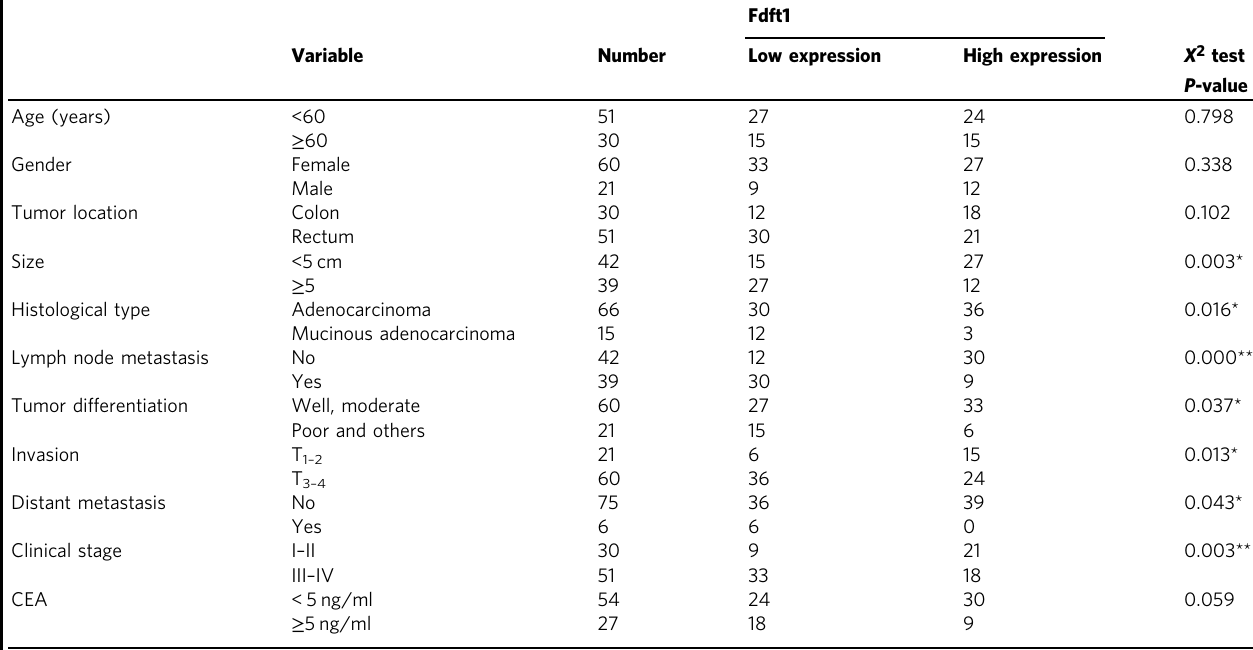
Table 1 The relationship between Fdft1 expression and clinicopathological features in 81 CRC patients from